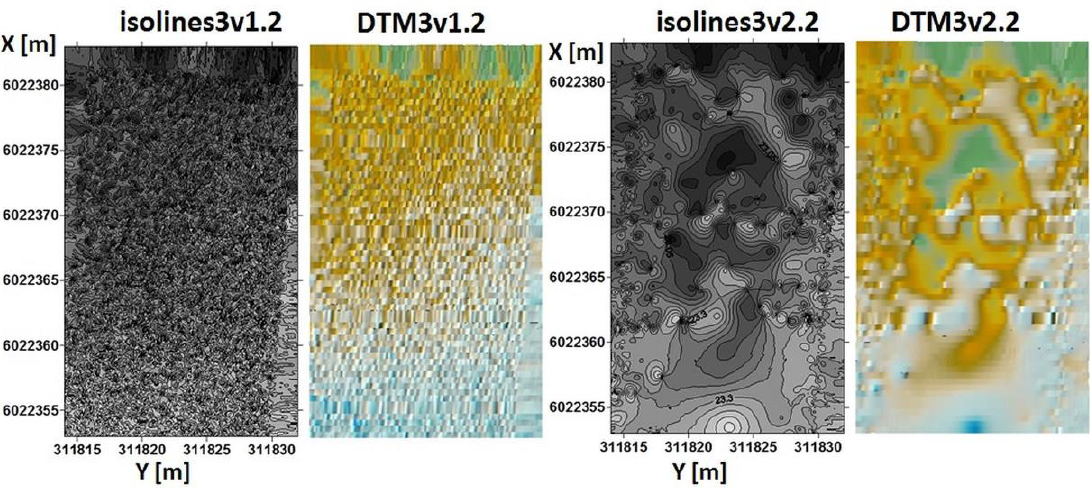
Figure 13. Isolines2v1.2 and DTM2v1.2, and isolines2v2.2 and DTM2v2.2 generated for strip 2 (po 2 ) by methodologies v1.2 and v2.2, respectively.